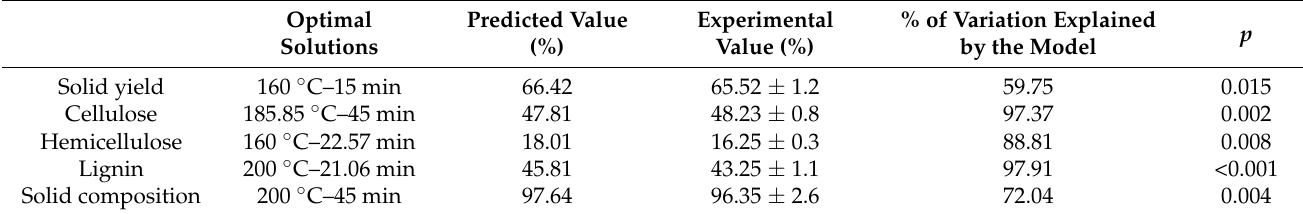
Table 8. Prediction and optimization report obtained from multiple